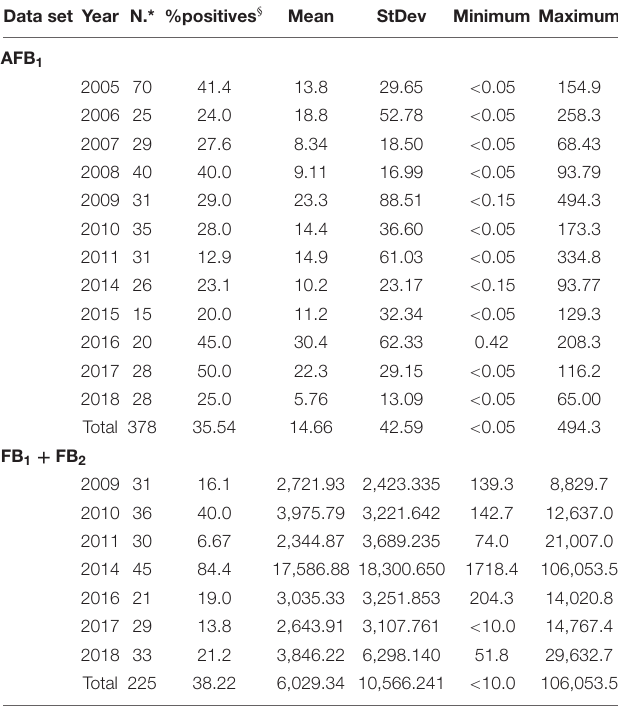
TABLE 2 | Descriptive statistics of aflatoxin B1 (AFB 1 ) and fumonisins (FBs, intended as the sum of FB 1 + FB 2 ) levels of contamination ( µ g/kg) in maize grain samples collected in Emilia Romagna, Italy, over the years 2005–2018 (with some exceptions both for AFB 1 and for FBs). Data set Year N.* %positives §